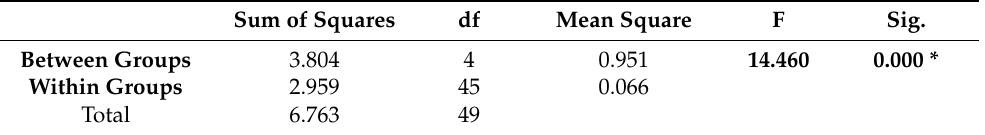
Cichorium ( p = 0.042), Rosmarinus vs. Taraxacum ( p = 0.001), Rosmarinus vs. Cichorium ( p = 0.020), Agrimonia vs. Taraxacum ( p = 0.001), and Agrimonia vs. Cichorium ( p = 0.017).